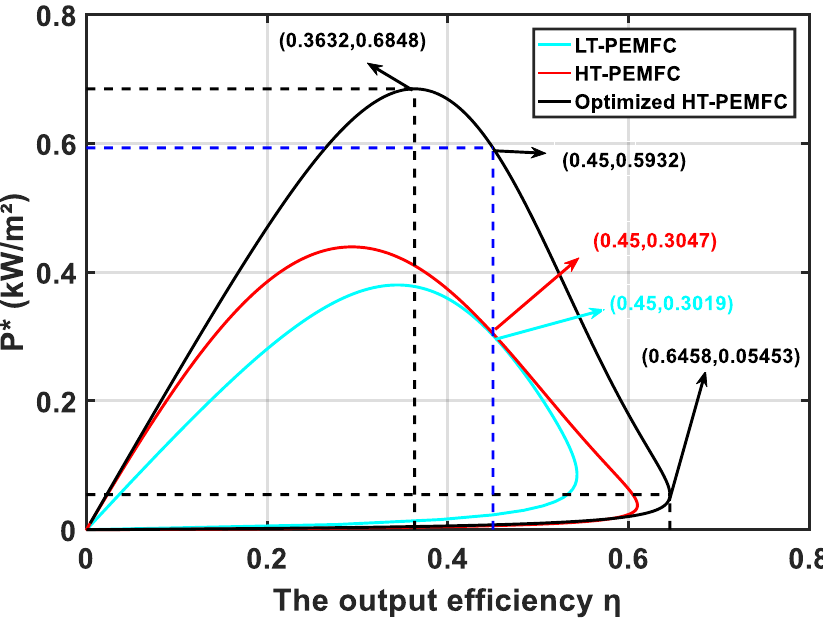
Figure 6. Comparison of P ∗ and η curves of the LT-PEMFC, HT-PEMFC, and optimized HT-PEMFC.